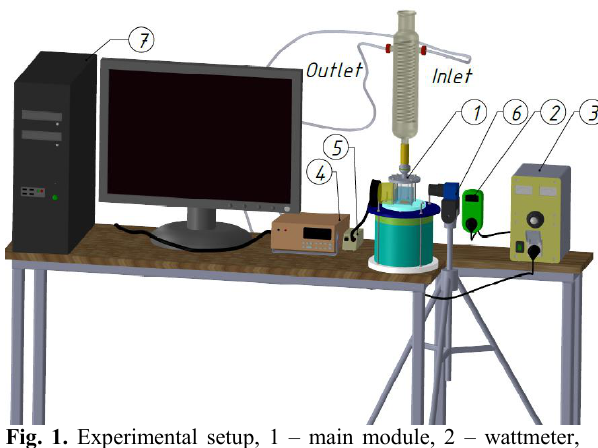
Fig. 1. Experimental setup, 1 – main module, 2 – wattmeter, 3 – autotransformer, 4 – data logger, 5 – light, 6 – high speed camera, 7 –